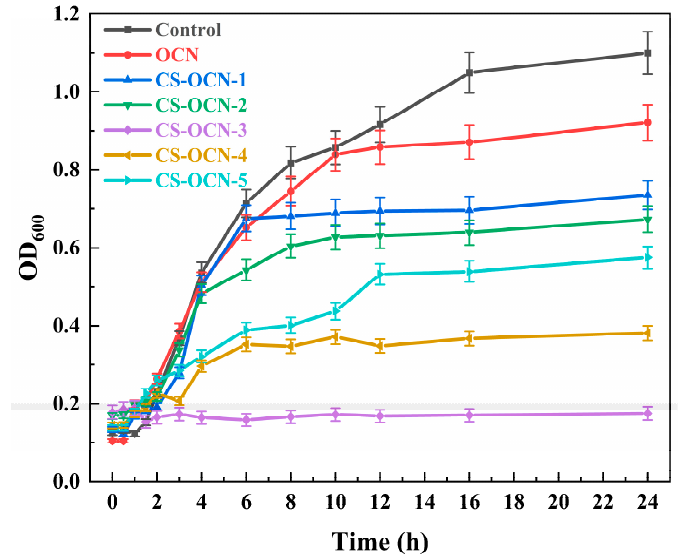
Figure 7. Bacterial growth curves of E. coli treated by OCN and